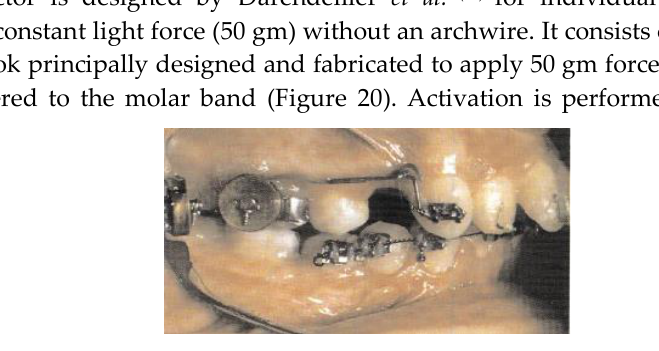
Figure 20: Drum spring